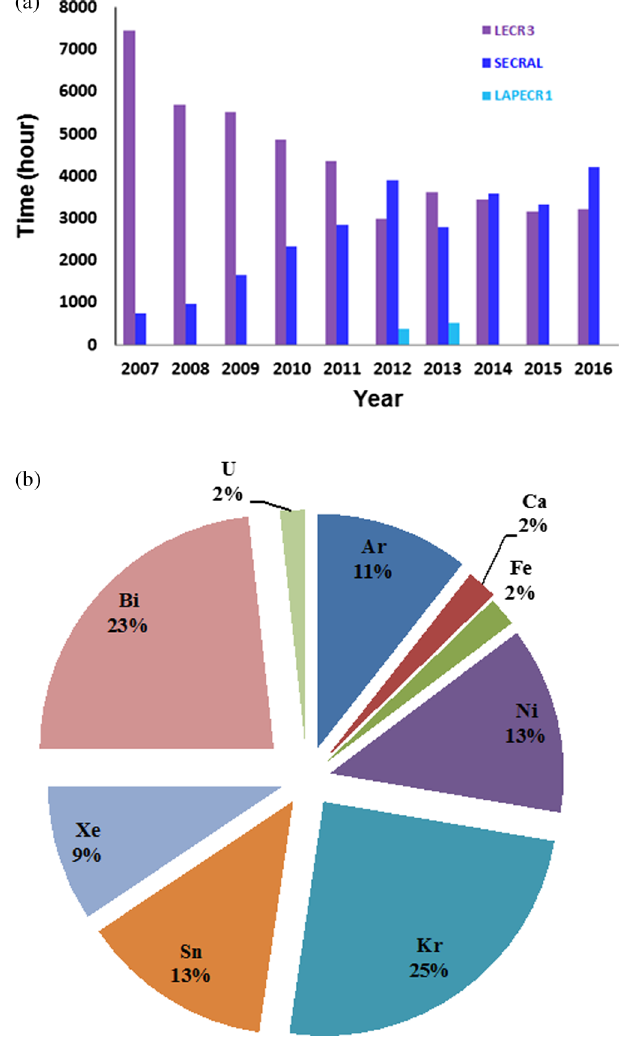
FIG. 28. SECRAL operation statistic data for the HIRFL accelerator. (a) Beam delivering time by SECRAL from May 2007 to December 2016 in comparison to LECR3. (b) Typical beams provided by SECRAL during operation for the HIRFL